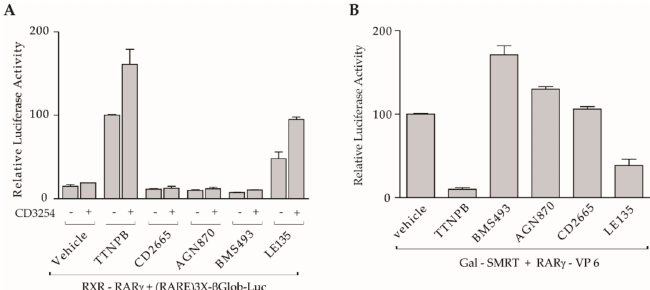
Figure 4. CD2665 and AGN870 do not synergize with CD3254 to activate RXR-RAR γ . ( A ) transient transactivation in COS cells co-transfected with the reporter (RARE)3x-tk-Luc and RAR γ and RXR expression vectors in the absence or in the presence of indicated retinoids used alone or with CD3254 (100%, TTNPB induced activity); ( B ) mammalian two-hybrid assay with (17m)5x- β Glob-Luc and VP16-RAR γ and Gal-SMRT was performed in COS cells to assess the influence of indicated retinoids on interaction between RAR γ and CoRs (100%, basal transcriptional activity). Compounds were used at 1 µ M in all two-hybrid assays. Error bars,